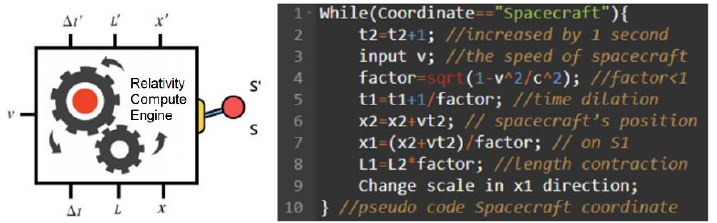
Figure 5. Relativity compute engine (switching to the spacecraft coordinate system).